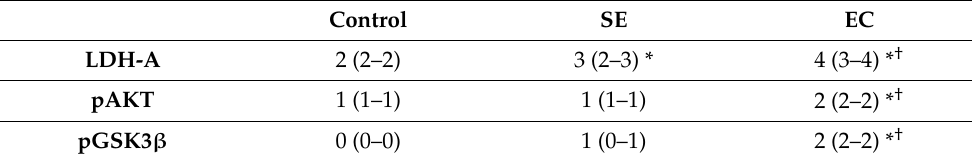
Table 3. LDH-A and PI3K pathways in control and TGCTs.